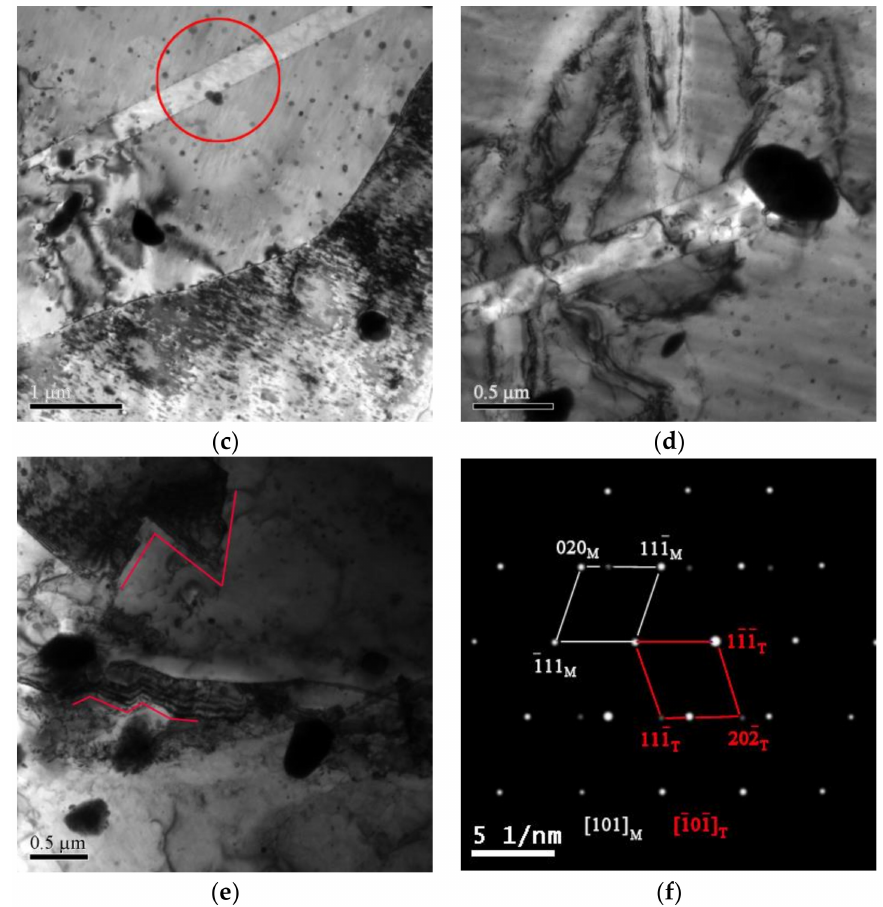
Figure 7. The BF and SAED of the twins of the studied alloy under different annealing temperatures: ( a , b ) 873 K and ( c – e ) 973 K; ( f ) the SAED of twins for the circular selection region in ( c